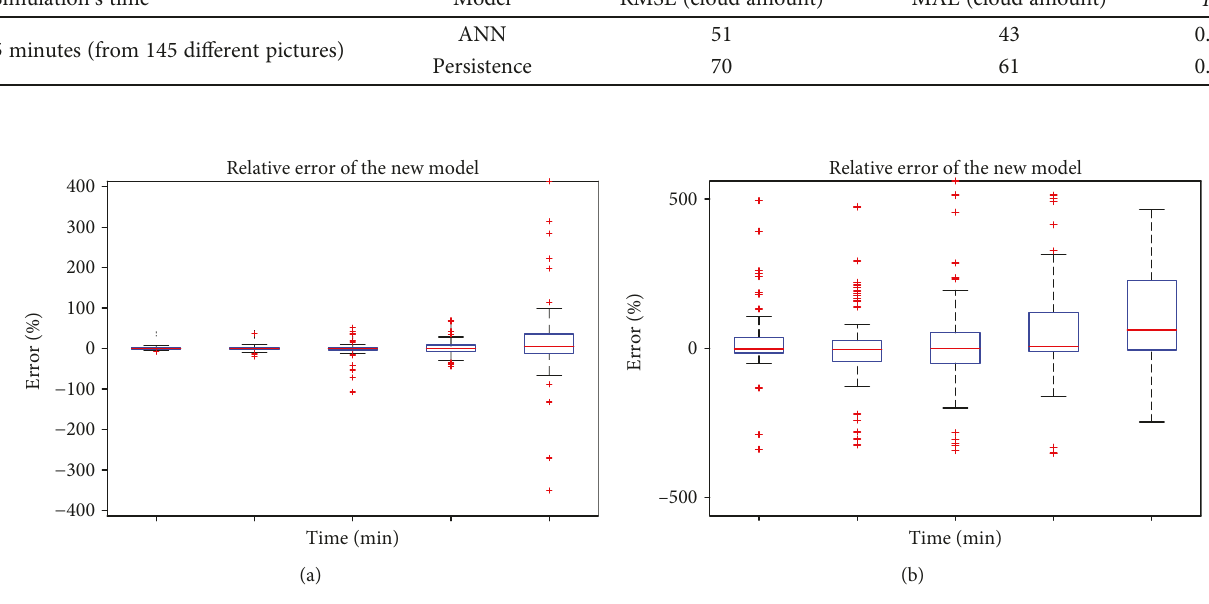
Figure 7: Relative deviation as boxplot for the fi rst fi ve minutes. (a) corresponds to the new ANN. Here, we can see that the deviations are narrower concentrated in the middle interquartile ranges. (b) corresponds to the persistence model. 50% of the deviations are not exactly located in the middle. In addition, the 25% and 75% of the deviation is higher than in